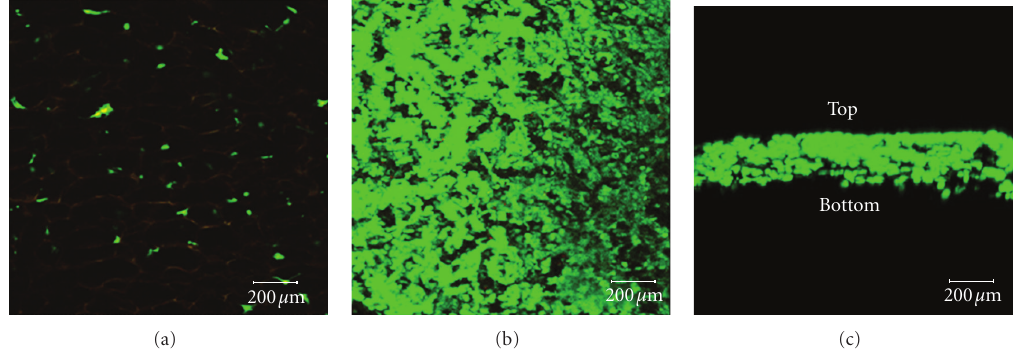
Figure 5: Live/dead cell staining of pHDF cultures seeded on CPSRTs. (a) Three-dimensional (3D) surfaces were scanned using a CLSM at day 5. (b) Viable pHDFs (green) were confluent at day 14. (c) Cross-sectional view of a CPSRT seeded with pHDFs at day